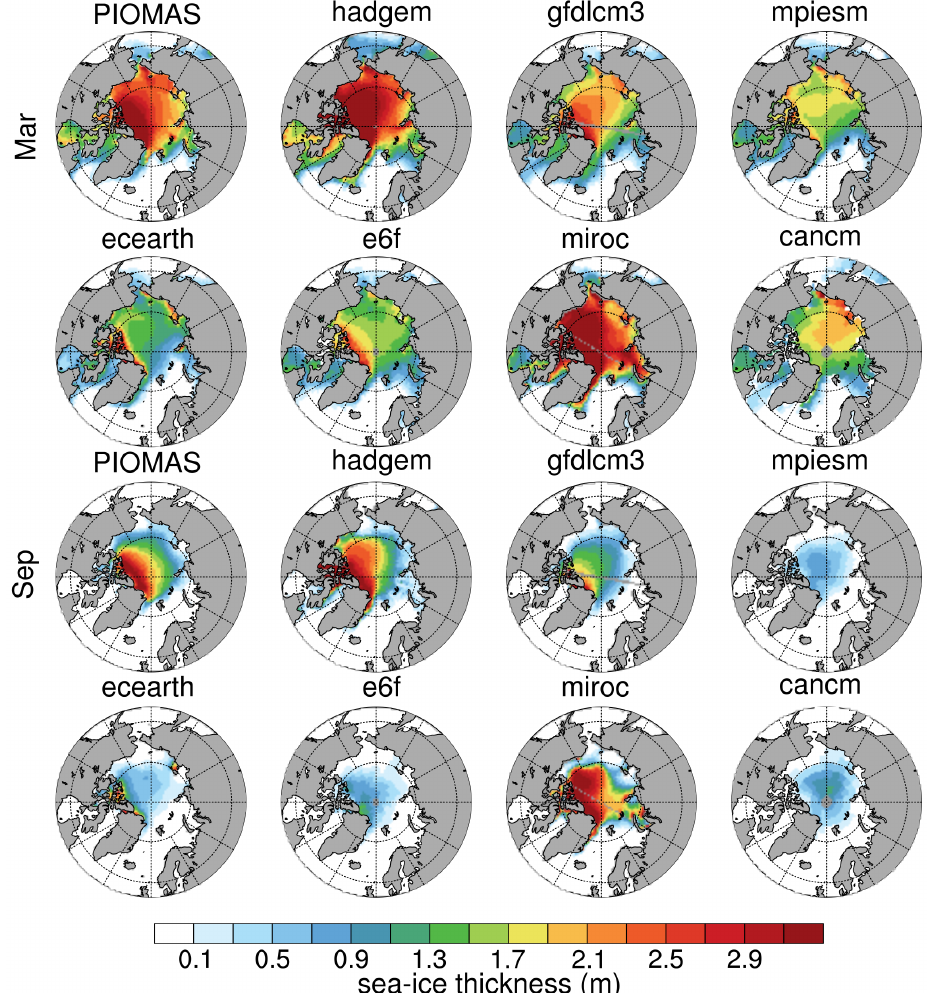
Figure 3. Average sea ice thickness in present-day model control simulations and from PIOMAS (1983–2012) (Schweiger et al.,